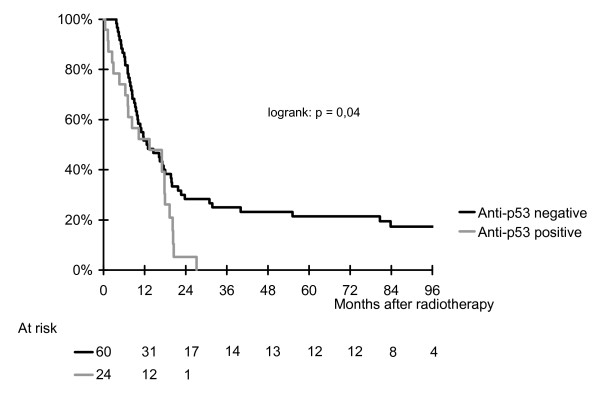
Kaplan-Meier curve of overall survival according to anti-p53 antibody status.